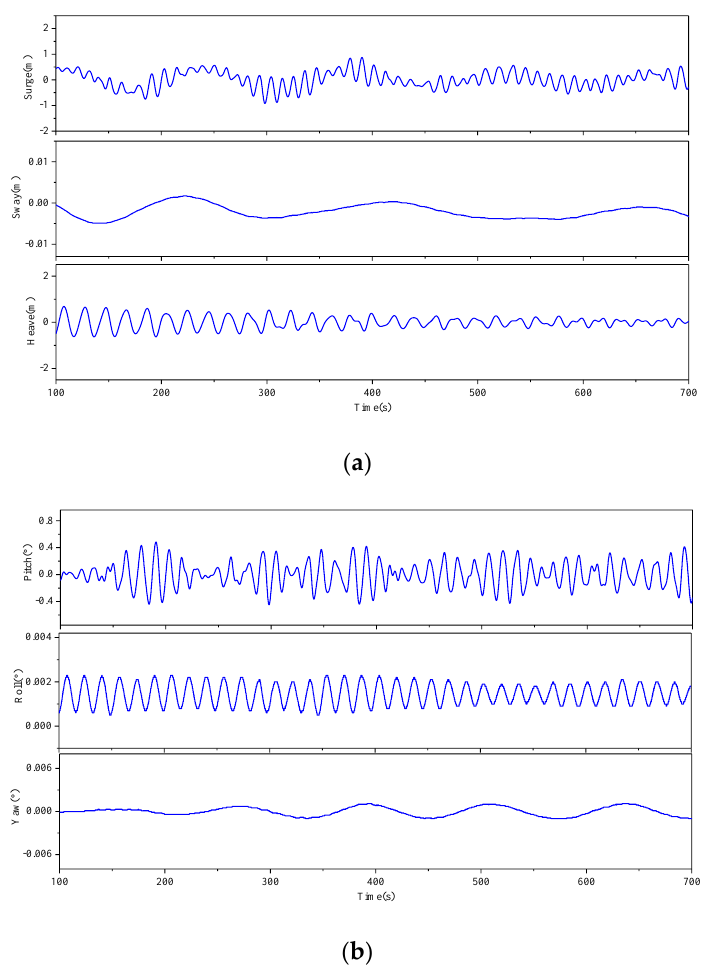
Figure 11. Time histories of cage motions under the uniform wind with regular waves. ( a ) Translational motion . ( b ) Rotational motion .